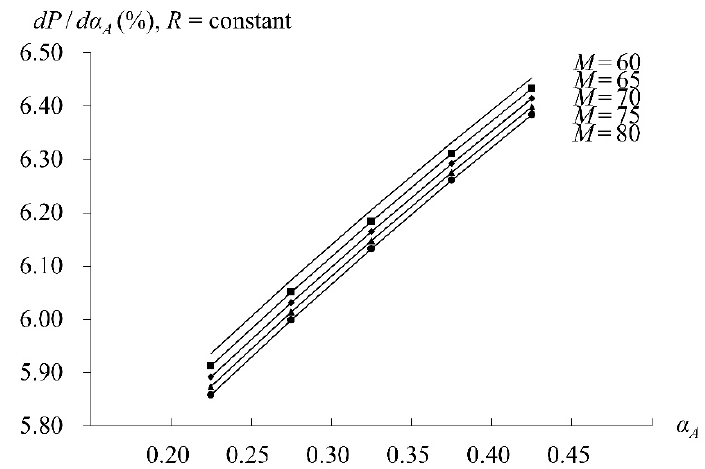
Figure 1. Responsiveness of default risk to overconfidence degree at various levels of shadow-banking transaction based on Equation (14). Parameter values, unless stated otherwise, δ = 0.65, σ = 0.30, m = 0.10%, α = 0.95, R M = 5.00%, R B = 4.00%, β = 0.60, θ = 0.40, and R = 2.25%. All results are valued at the optimal R A of 5.60%. The negative indirect effect, ( ∂ P / ∂ R A )( ∂ R A / ∂α A ) < 0, is consistently insufficient to offset the positive direct effect, ∂ P / ∂α A > 0 at various levels of shadow-banking transaction.